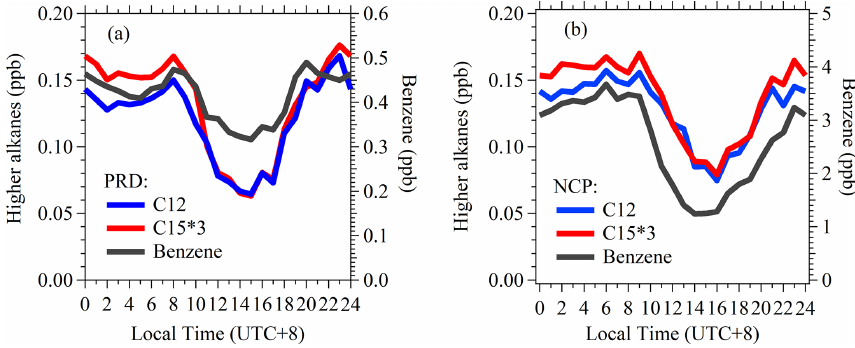
Figure 7. Diurnal variations of C12 alkanes, C15 alkanes, and benzene in PRD (a) and NCP (b)